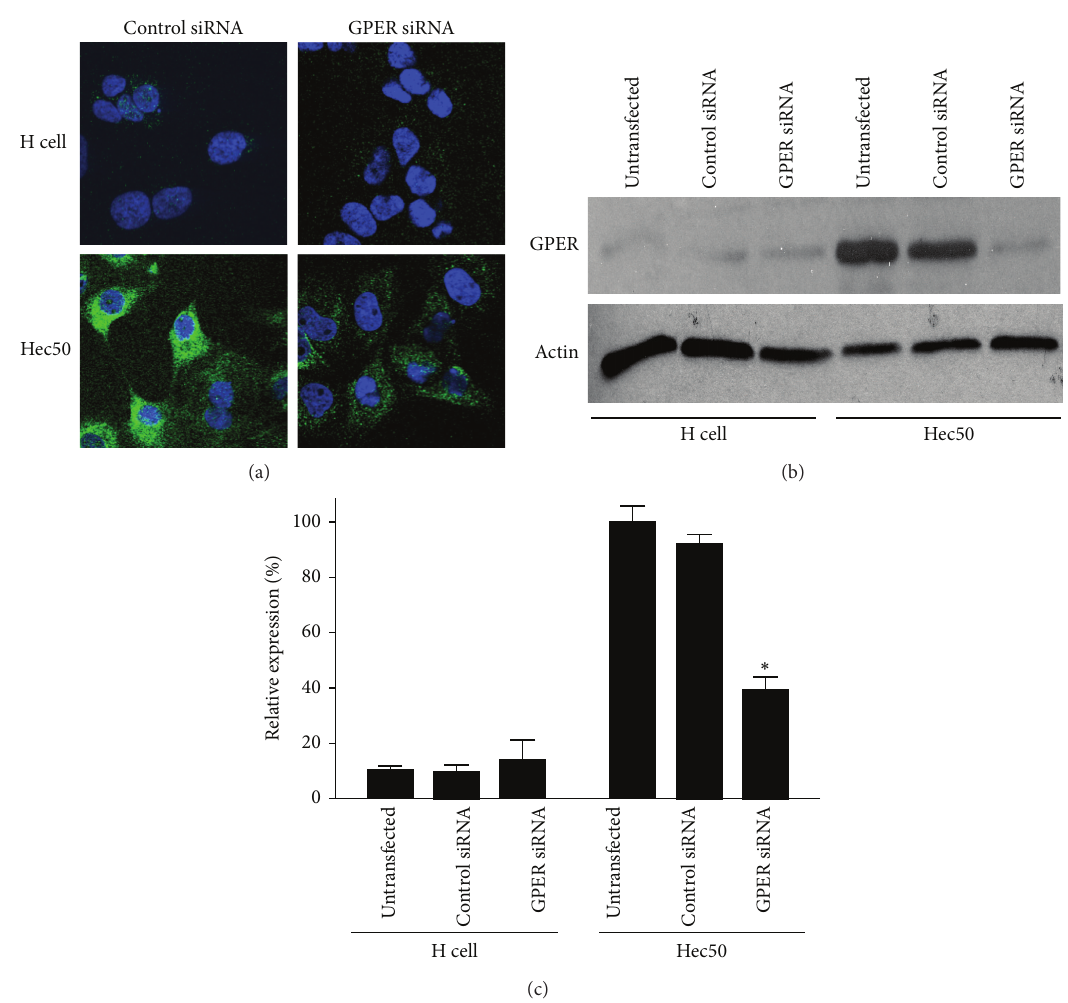
Figure 1: GPER expression in type I and type II endometrial cancer cells. (a) Representative immunofluorescence images of Ishikawa H cells (type I) and Hec50 cells (type II) transfected with either control siRNA or siRNA targeting GPER. GPER is shown in green; nuclei are stained blue with DAPI. (b) Western blot of GPER and actin in untransfected, control siRNA- and GPER-targeted siRNA-transfected H cells and Hec50 cells. (c) Western blot quantitation of GPER expression relative to actin and normalized to untransfected Hec50 cells. Data represent mean ± s.e.m. from three experiments. ∗ 𝑃 < 0.05 compared to control